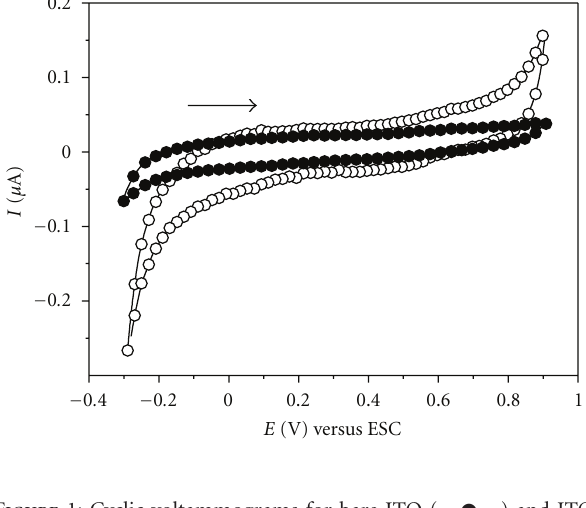
Figure 1: Cyclic voltammograms for bare ITO (— (cid:2) —) and ITO modified with (PAH/CG) 6 LbL films (— (cid:4) —) in HCl 0.1 mol/L at 50mVs − 1 .